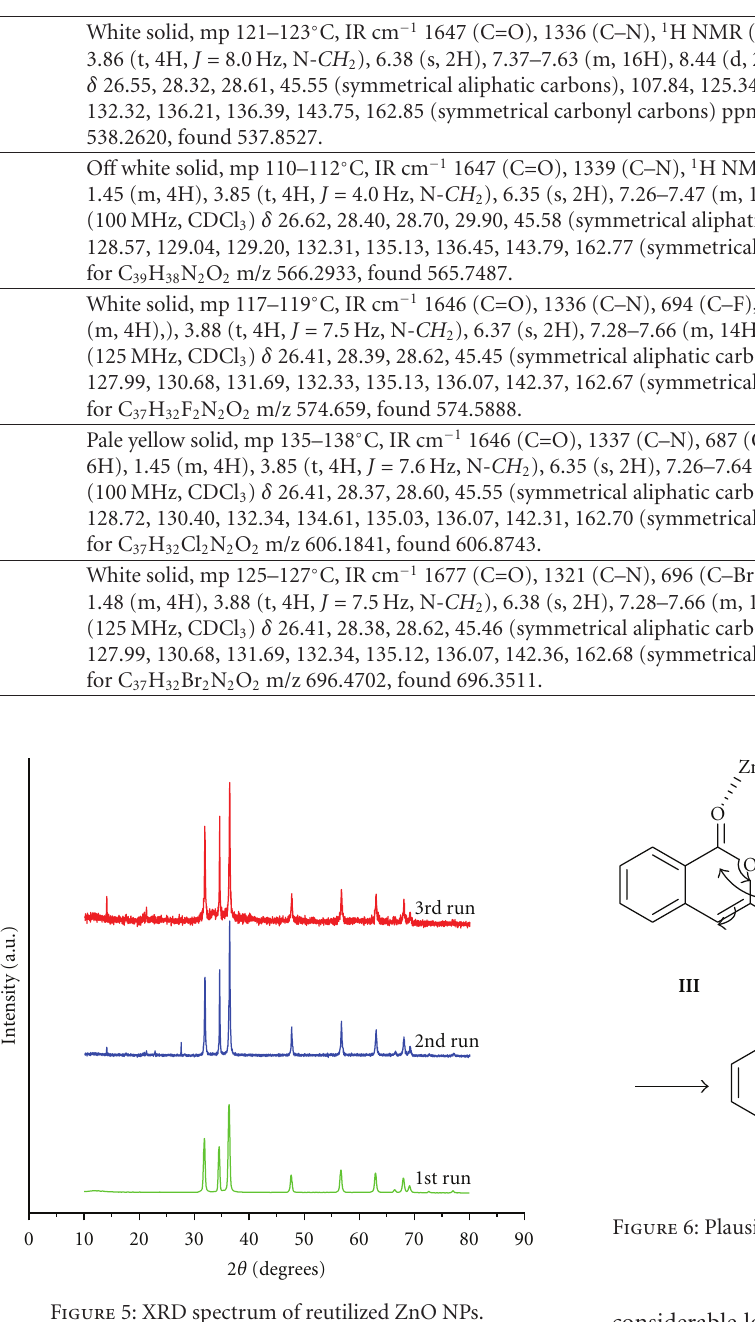
Table 4: Physical data.